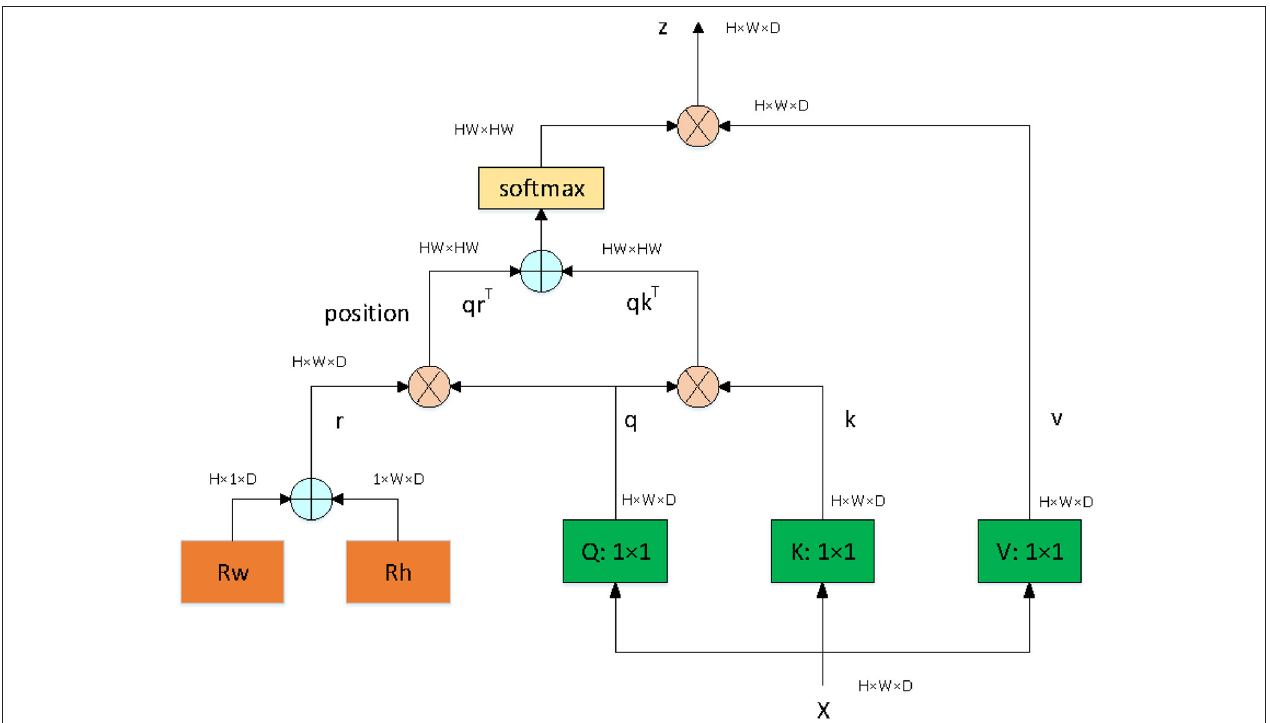
FIGURE 3 | The architecture of MHSA